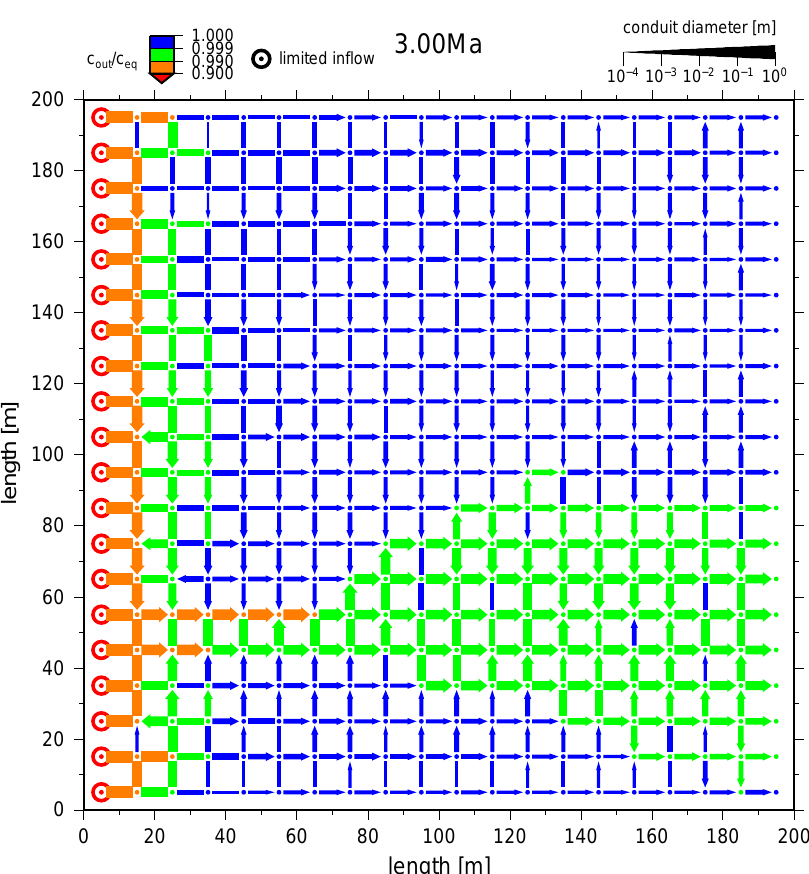
Fig. 10. Conduit pattern of the realisation shown in Fig. 9 but for the intermediate case with Q max = 10 − 7 m 3 s − 1